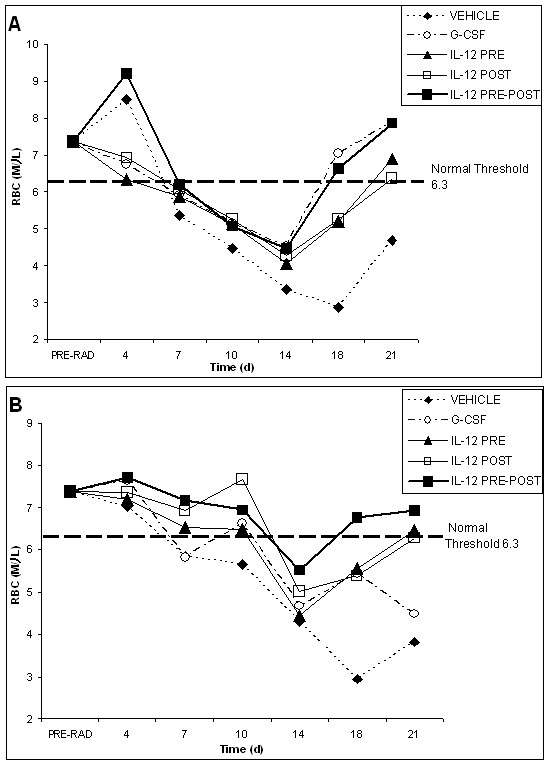
Red blood cell recovery profiles for vehicle, G-CSF, IL-12 pre-only, IL-12 post-only and IL-12 pre-post treatment groups following radiation (625 rad). Red blood cell recovery profiles are shown for the EL4 tumor model in (A) and the Lewis lung cancer model in (B). Pre-radiation blood values reflect an average of all animals in both groups (70 mice) before radiation and tumor inoculation. The normal threshold value for murine red blood cell counts is indicated. Following the initial dose of vehicle or cytokine, 4 subsequent doses were given every 3–4 days following radiation. IL-12 treated mice received a total dose (5 single doses) of 220 ng, whereas G-CSF treated mice received a total dose (5 single doses) of 5 μg.